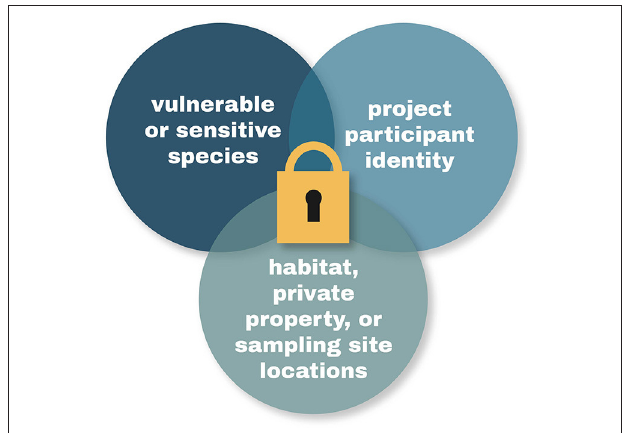
FIGURE 6 | Themes emerging from project administrator feedback. Expressed needs for data privacy included private fields for species data, geoprivacy for private property and sample site locations, and anonymity for project participants, in particular, schoolchildren.